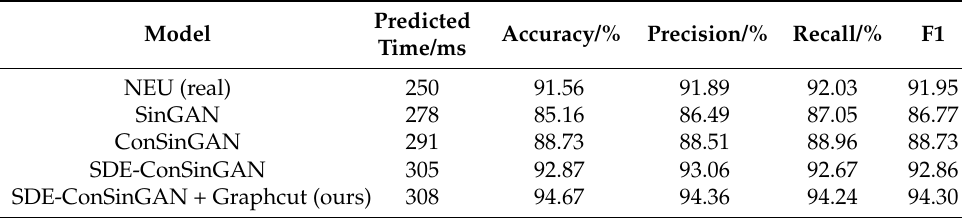
Table 6. Defect classification performance of different image-generation